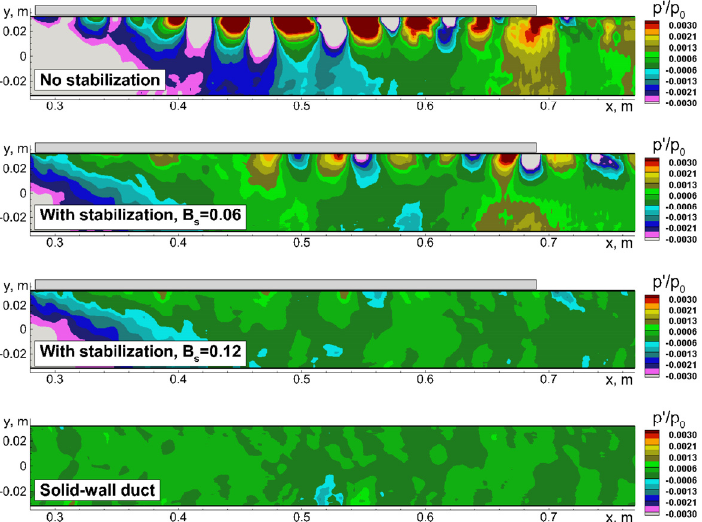
Figure 24. E ff ect of stabilization (10) and its amplitude parameter B s on instantaneous fi eld of pres- Figure 24. Effect of stabilization (10) and its amplitude parameter B s on instantaneous field of pressure